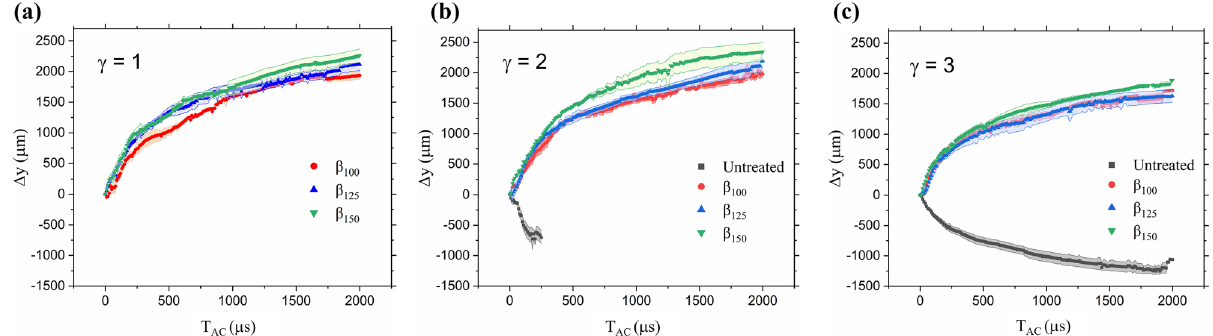
Figure 8. Average displacement of cavitation bulk volume following collapse near microstructure samples and an untreated PDMS at ( a ) γ = 1, ( b ) γ = 2, and ( c ) γ = 3. Displacements shown correspond to a single cavitation event formed above pristine samples. T AC = 0 µs depicts moment of cavitation bubble collapse. Positive displacement is migration away from